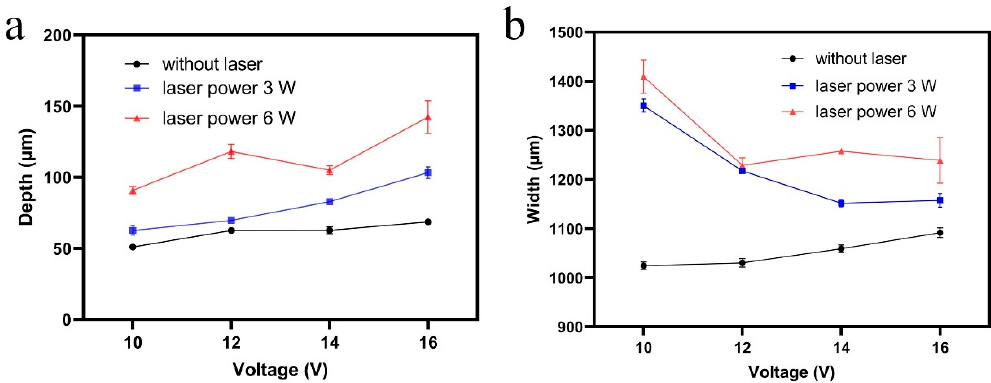
Figure 8. Variation of the ( a ) depth and ( b ) width of the microgrooves processed by Laser-STEM with voltage and laser power.